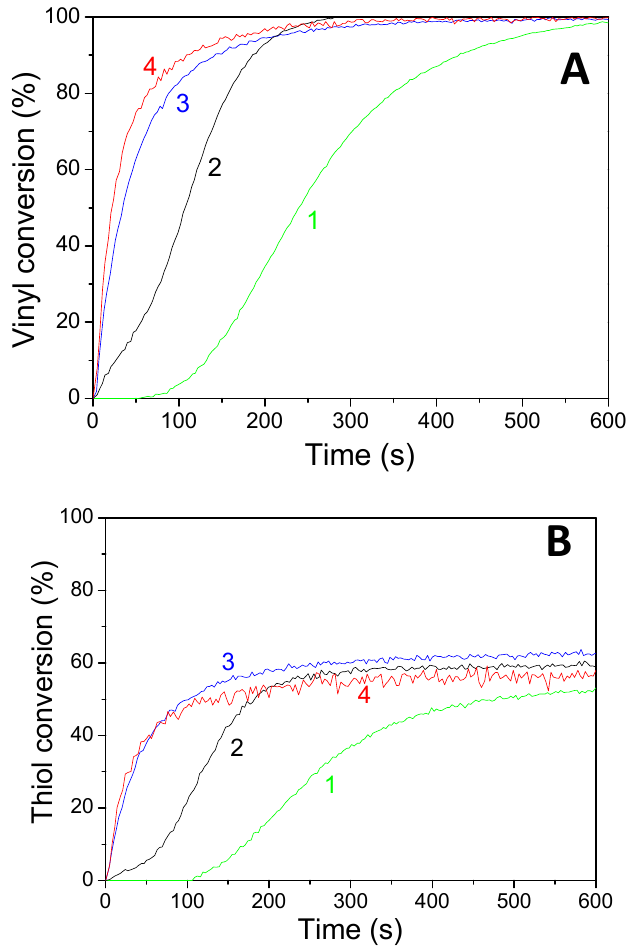
Figure 7. Kinetic profiles for the thiol–ene reaction of limonene 1,2 epoxide (50 wt%)/trithiol (50 wt%) blend mixture with HNQE /Iod (0.5/2%, w / w ) photoinitiating system, upon (1) LED@385 nm and (2) LED@405 nm under air; and in laminate under (3) LED@385 nm and 4) LED@405 nm. ( A ) Vinyl conversions and ( B ) thiol conversions. Table 6. Vinyl, thiol, and epoxy final conversions (determined by IR) after 600s of irradiation of limonene1,2 epoxide/tri- thiol (50 wt %/50 wt%) blend mixture under LED@385nm (44 mW/cm 2 ) and LED@405nm (60 mW/cm 2 ) irradiation under air and in laminate. Photoinitiating systems = HNQA /Iod (0.5/2%, w / w ) and HNQE /Iod (0.5/2%, w / w ).